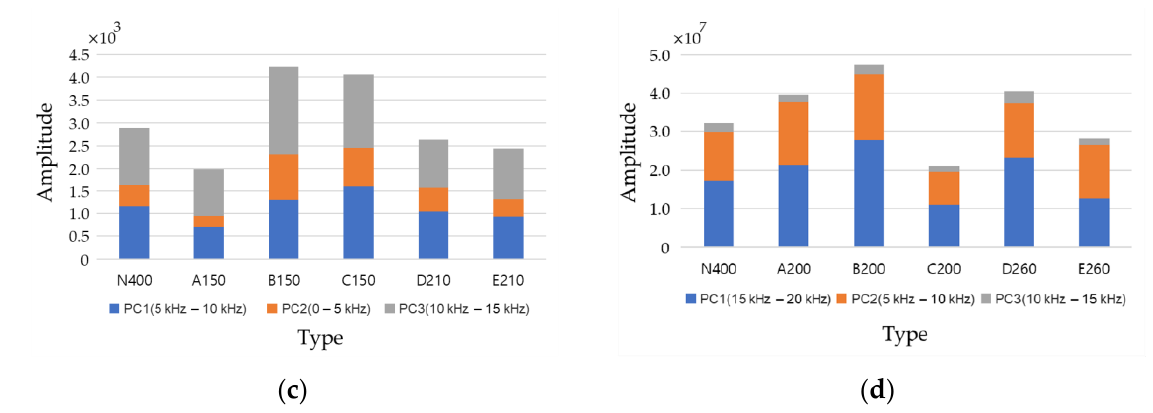
Figure 16. Average of eight sensors for the extracted features. ( a ) d50, ( b ) d100, ( c ) d150, ( d ) d200.